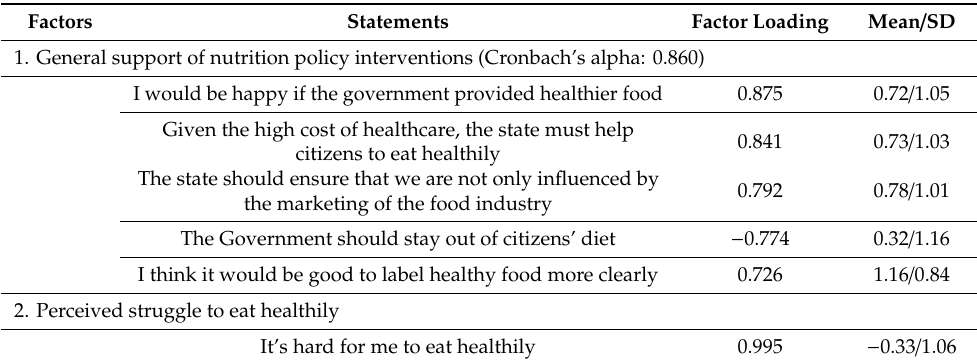
Table 3. Results of principal component analysis and Cronbach’s alpha.